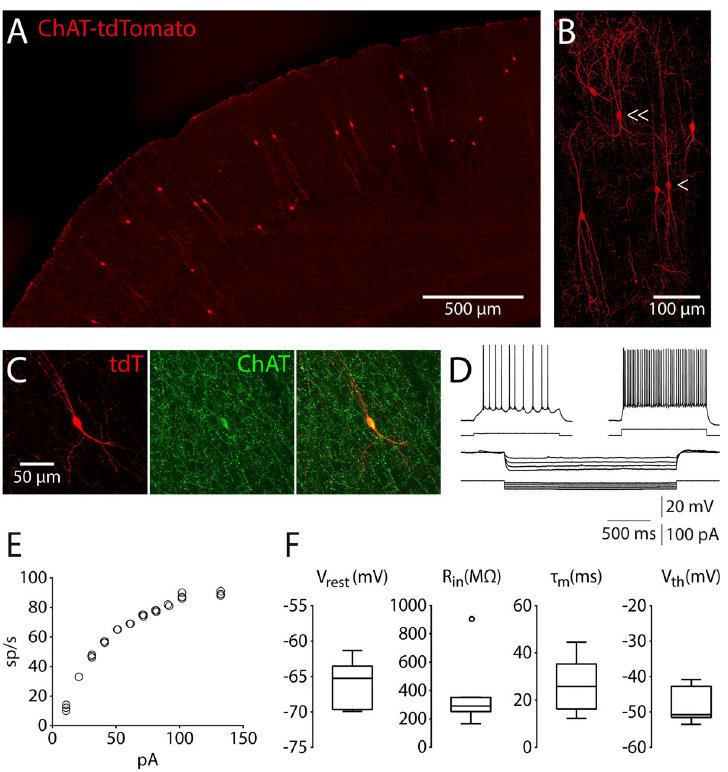
Fig 2. Anatomical and physiological properties of tdTomato-expressing cells in ChAT-tdTomato mice. (A) Image of a ChAT-tdTomato mouse cortex (30- μ m coronal slice). (B) Three-dimensional rendering of VChIs in a coronal slice from a ChAT-tdTomato mouse (cube 300 × 700 × 150 μ m; see S1 Video). (C) Expression of ChAT in cortical tdTomato-expressing cells. Left: tdTomato; Middle: ChAT staining (Alexa 648); Right: overlay. (D) Membrane potential responses to hyperpolarizing and depolarizing current steps of a cortical tdTomato-expressing cell. (E) F-I curve of the recorded cell shown in panel D. (F) Physiological properties of the recorded cells. τ m , membrane time constant; ChAT, choline acetyltransferase; F-I, frequency-current; R in , input resistance; sp/s, spikes per second; V rest , resting potential; V th , threshold potential; VChI, VIP/ChAT interneuron; VIP, vasoactive intestinal polypeptide. isoflurane-anesthetized mice (Fig 3A and 3B). Cells were electroporated at the end of the experiment for targeting validation (only cells filled with Alexa 488 were included in analysis).